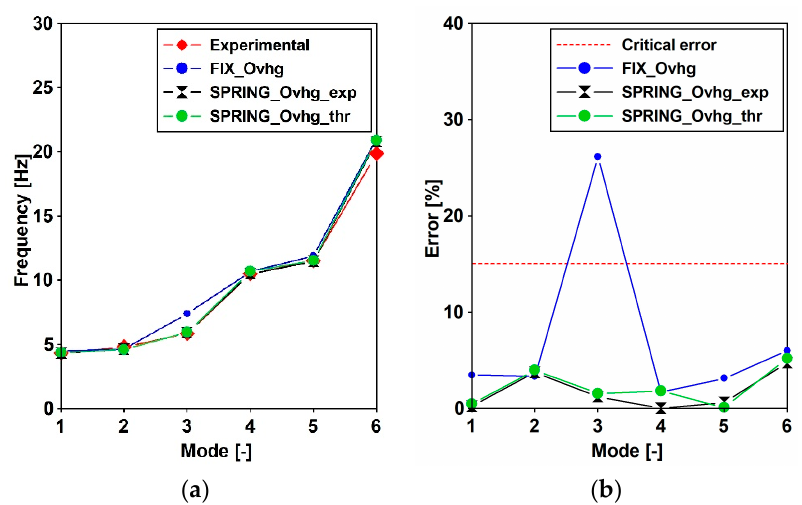
Figure 17. Sensitivity of the natural frequencies vs. adopted model: ( a ) evaluated values [Hz]; ( b ) percentage error.